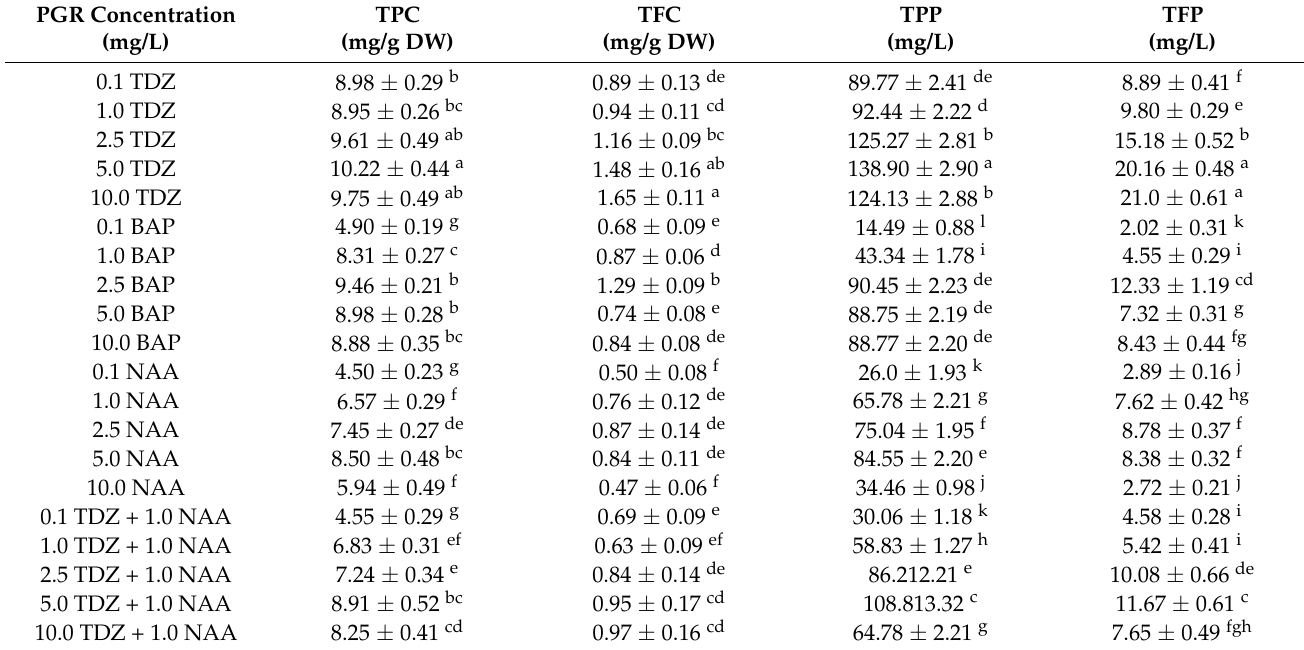
Table 2. Total phenolic and total flavonoid analyses of S. virginianum -treated